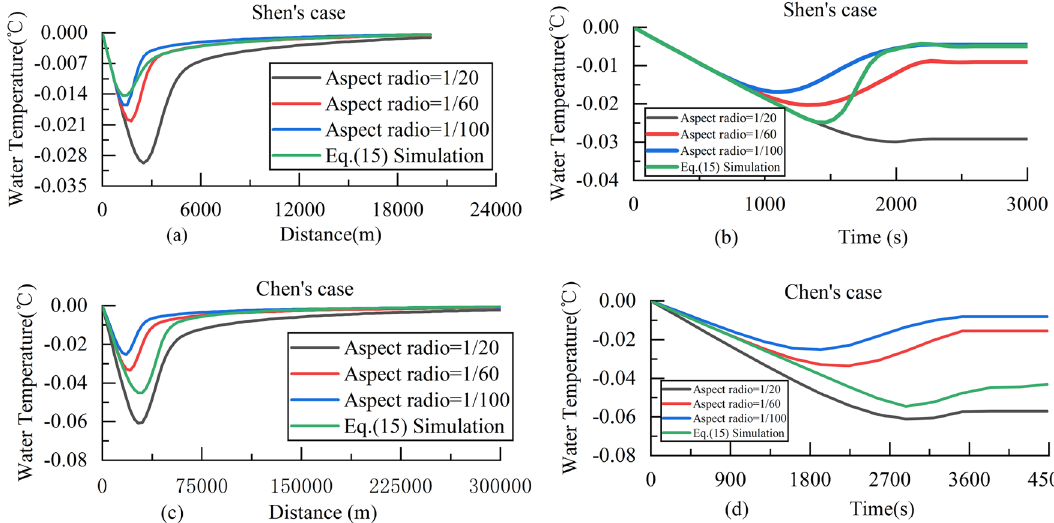
Figure 3. ( a ) Water temperature along the lines for Shen’s case. ( b ) Water temperature versus time for Shen’s case. ( c ) Water temperature along the lines for Chen’s case. ( d ) Water temperature versus time for Chen’s